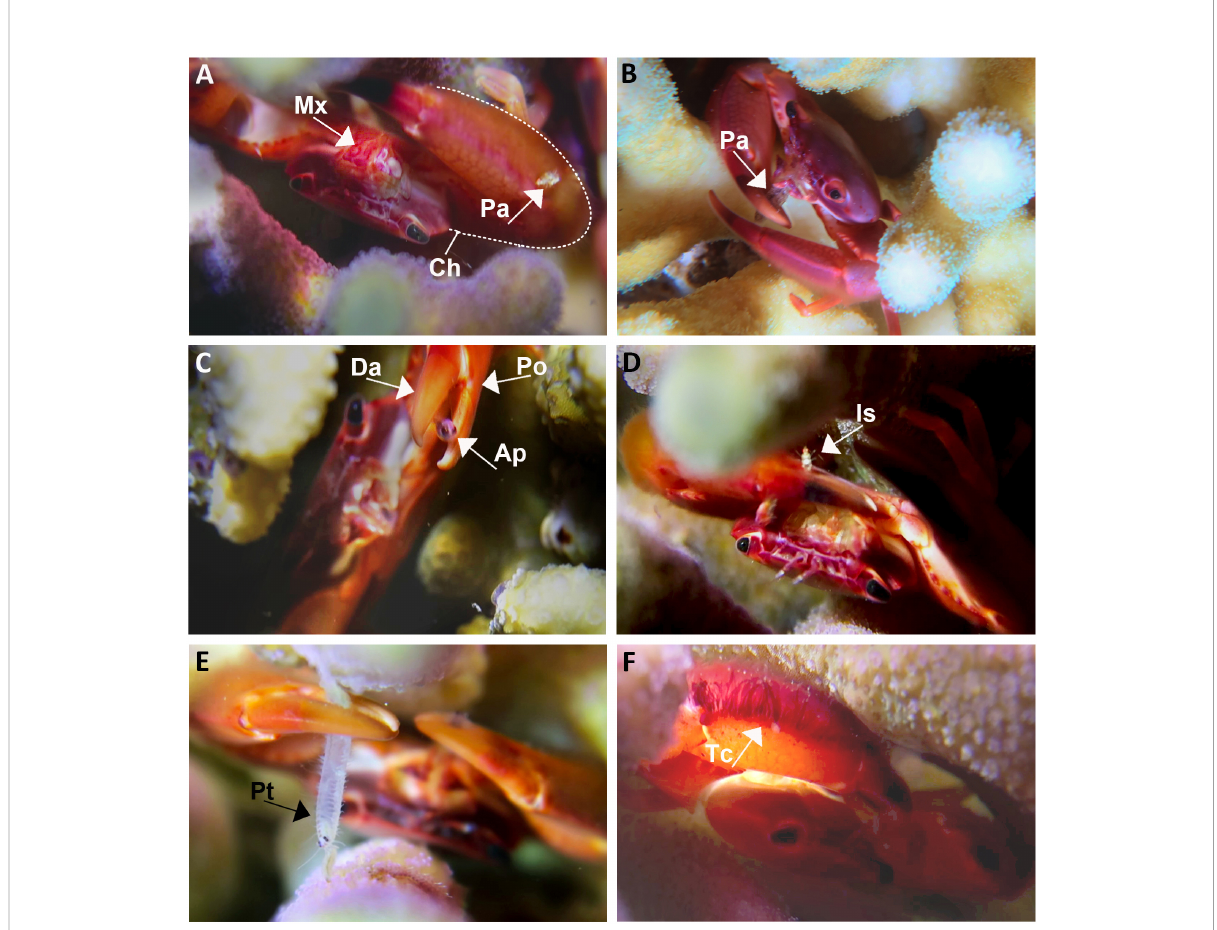
FIGURE 1 In-situ documentation of Trapezia cymodoce feeding behaviors. (A) Trapezia with extended open chelipeds (Ch) and with continuously moving maxillipeds (Mx), tomentose chela with a captured planktonic animal (Pa). (B) Trapezia actively consuming a planktonic animal (Pa) using its cheliped. (C) An escaping amphipod (Ap) catches between the dactylus (Da) and pollex (Po) of a Trapezia cheliped (also see Video S1). (D) An isopod (Is) captured by Trapezia cheliped (also see Video S1). (E) A polychaete (Pt) caught by the Trapezia chelipeds. (F) Close up on tomentose chela (Tc).